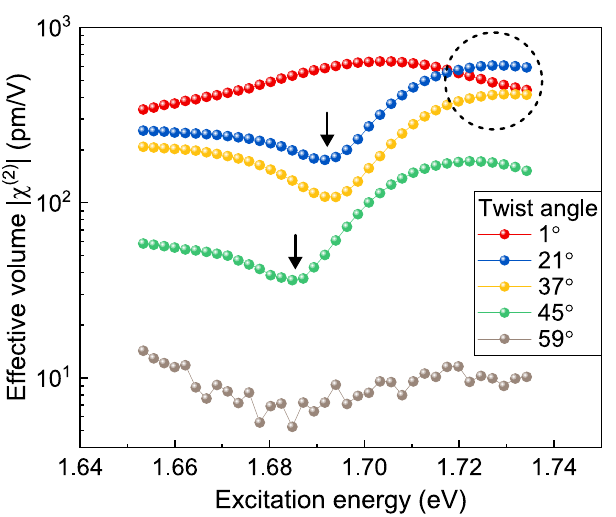
Fig. 3 Experimental frequency dependence of the effective second-order nonlinear susceptibility as a function of twist angle in bilayer WSe 2 at 5 K. The dashed circle highlights the region where the 21° twisted bilayer exceeds the 1° sample in χ ð 2 Þ due to the shift of the excitonic resonances. The black arrows mark the suppression of χ ð 2 Þ due to the quantum